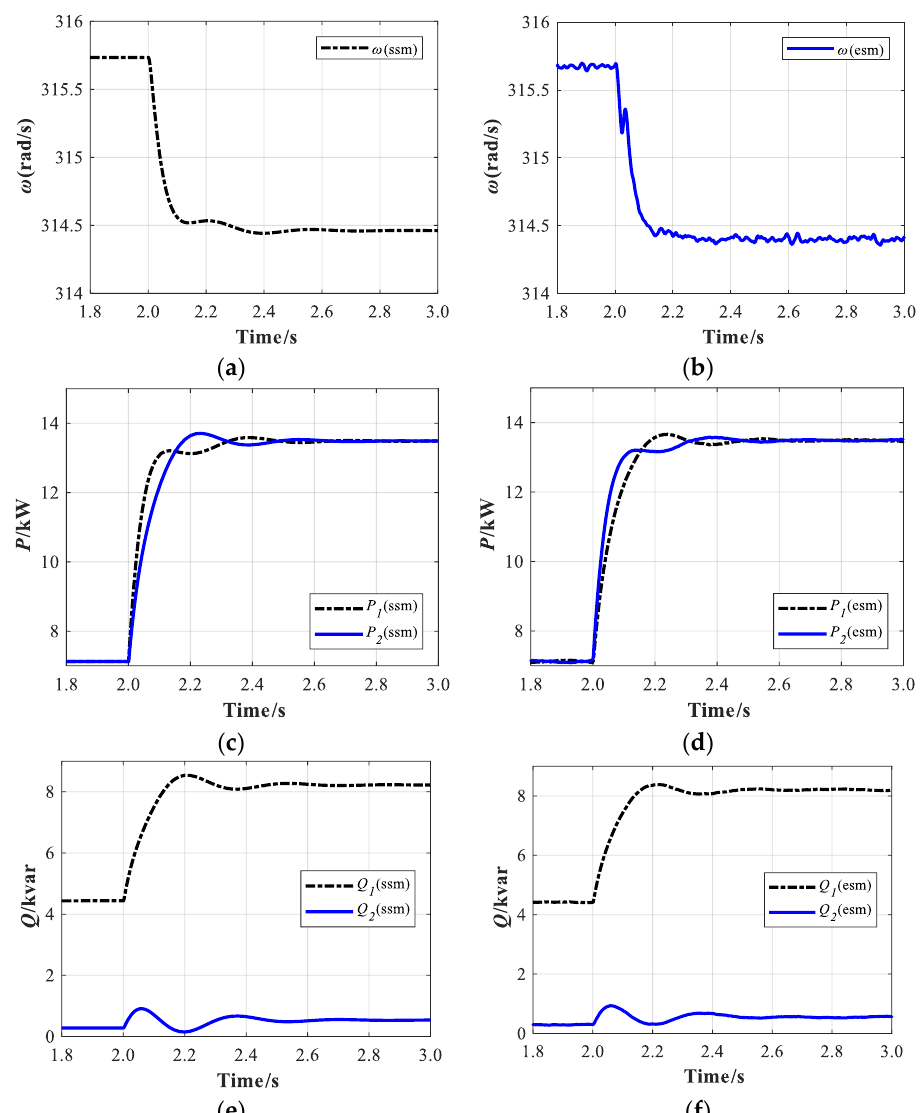
Figure 10. Transient impact of the electrical simulation model and small-signal model with load perturbation: the angular frequency; and the active and reactive power: ( a ) The angular frequency at PCC in ssm; ( b ) The angular frequency at PCC in esm; ( c ) The active power of the two VSGs in ssm; ( d ) The active power of the two VSGs in esm; ( e ) The reactive power of the two VSGs in ssm; ( f ) The reactive power of the two VSGs in esm.